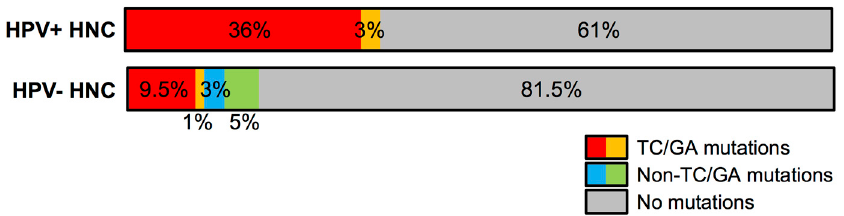
Figure 4. High levels of TC/GA mutations in the phosphatidylinositol-4,5-bisphosphate 3-kinase catalytic subunit alpha ( PIK3CA ) open reading frame in HPV-positive head and neck cancers (HNCs) compared to HPV-negative HNCs. Amino acid mutation data of PIK3CA in HNC patients was obtained from The Cancer Genome Atlas through cBioPortal (cbioportal.org) [149]: HPV-positive HNC (HPV+ HNC), n = 36; HPV-negative HNC (HPV- HNC), n = 243. Amino acid changes by TC/GA mutations are indicated as red (E542K and E545K) and orange (M1043V, R88Q, G1007R, G451R, R335G), and amino acid changes by non-TC/GA mutations are indicated as blue (H1047L, H1047R) and green (C604R, C901F, C971R, E110del, E365V, G363A, K111E, K111N, Q75E, R975S, V344G, W328S). Shown are the percentage of patients containing each mutation signature.